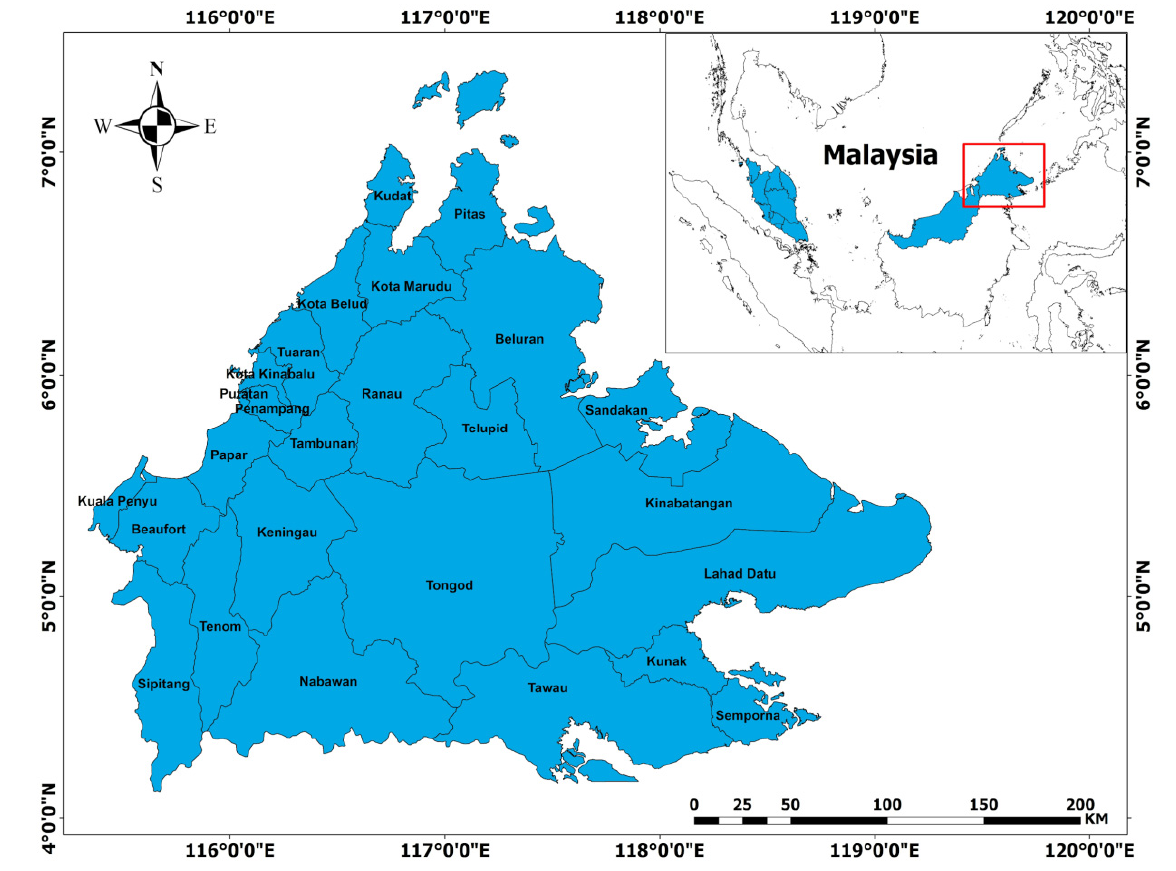
Figure 1. District position in Sabah, Malaysia.